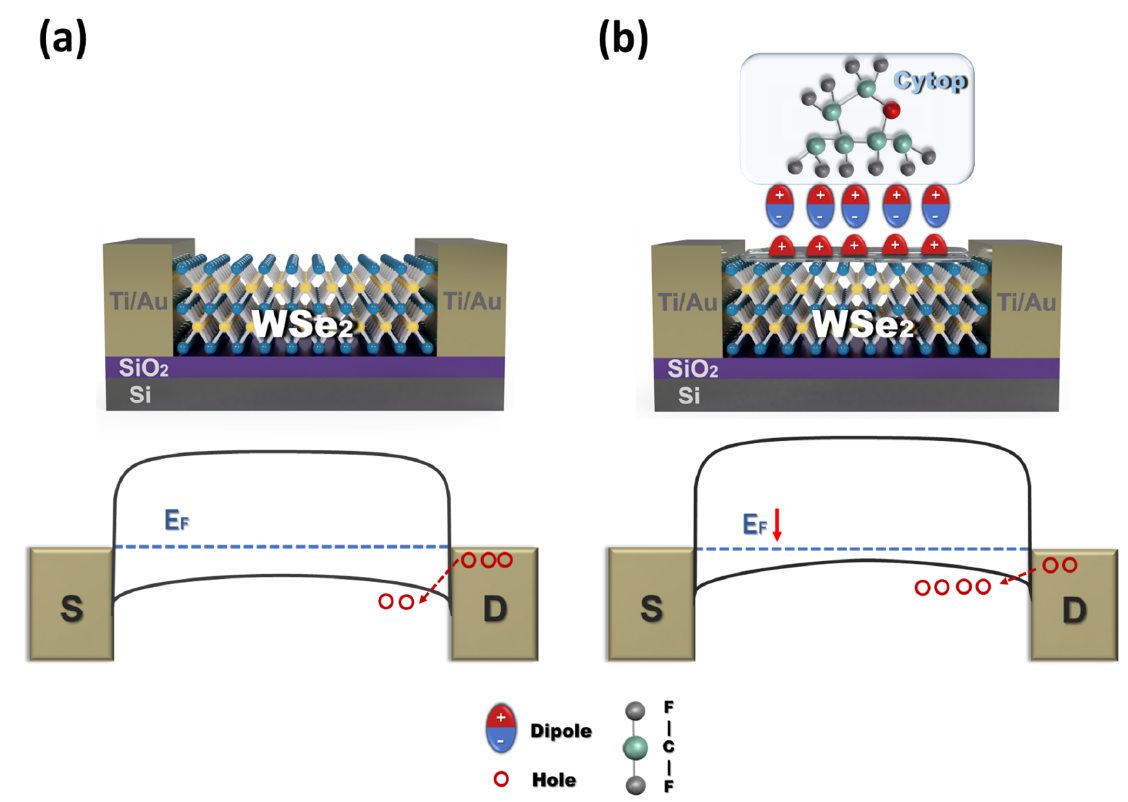
Figure 6. Schematics illustrating Cytop doping effects. Schematic and energy band diagram of the equilibrium state before and after doping with the Cytop layer. Cytop is a fluoropolymer with many C–F bonds. The dipole in Cytop induced by the C–F bond leads to holes in WSe 2 .